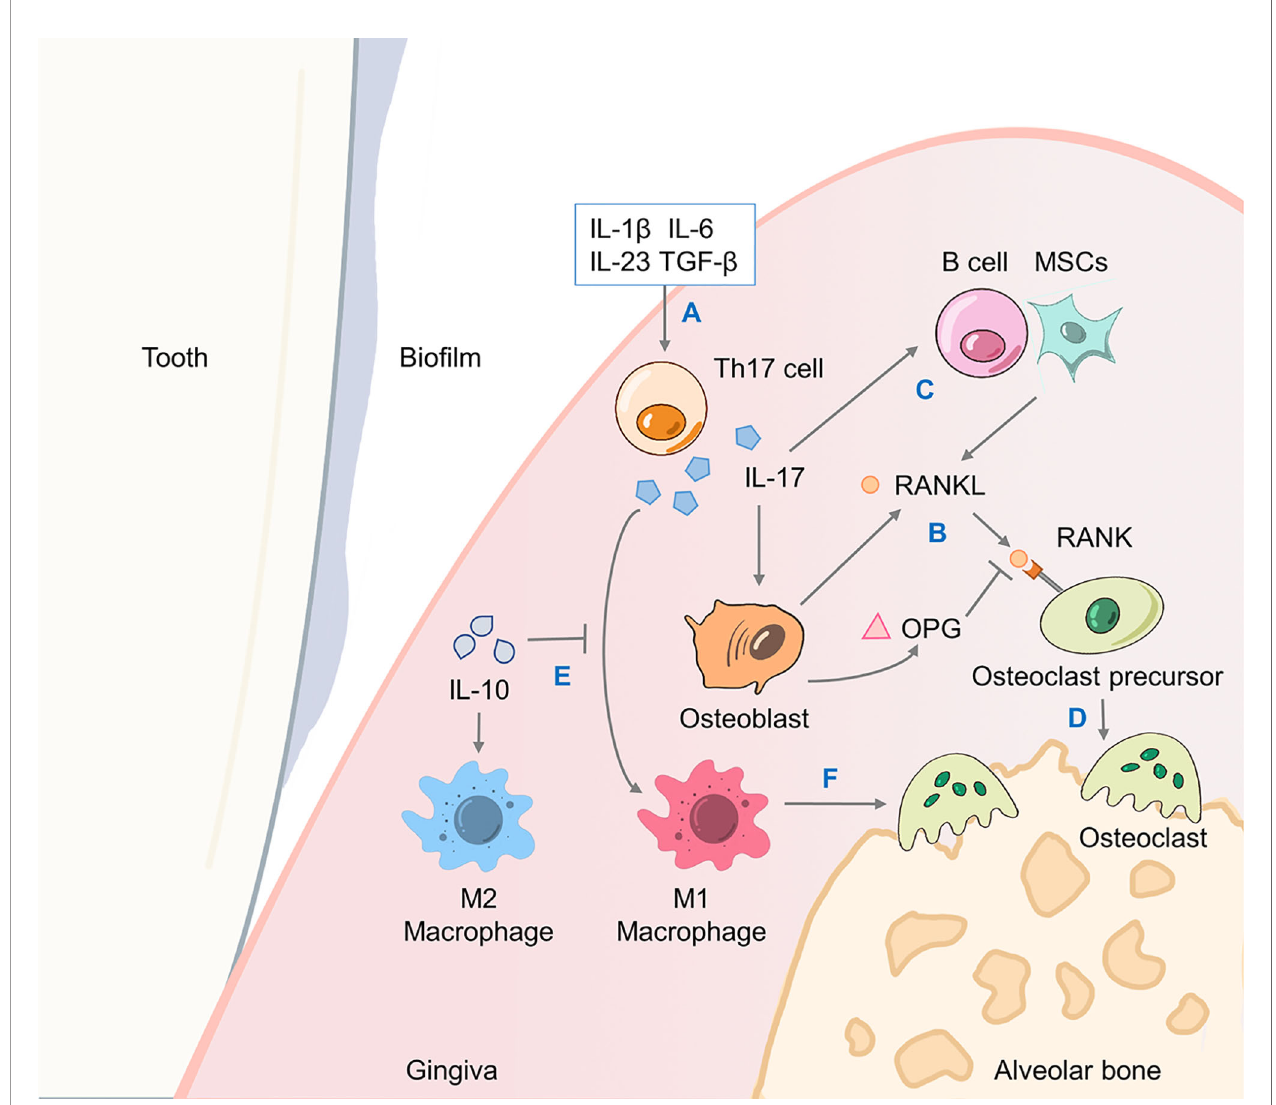
differentiation of Th17 cells and production of IL-17A. (B) Osteoblasts generate RANKL to bind to its receptor RANK on osteoclast precursor cells, as well as OPG to antagonize RANKL. (C) IL-17A-induced B cells and MSCs activation also promote RANKL production. (D) Osteoclast precursor cells differentiate and fuse into mature osteoclasts that causes alveolar bone resorption. (E) IL-17A mediates a proin fl ammatory M1 macrophage response which would be inhibited by IL-10, while IL-10 promotes M2 macrophage polarization. (F) M1 macrophages induce the production of proin fl ammatory cytokines such as IFN- g and IL-6 to exacerbate alveolar bone loss. OPG, osteoprotegerin; TGF- b , transforming growth factor- b ; MSC, mesenchymal stem cell; IFN,